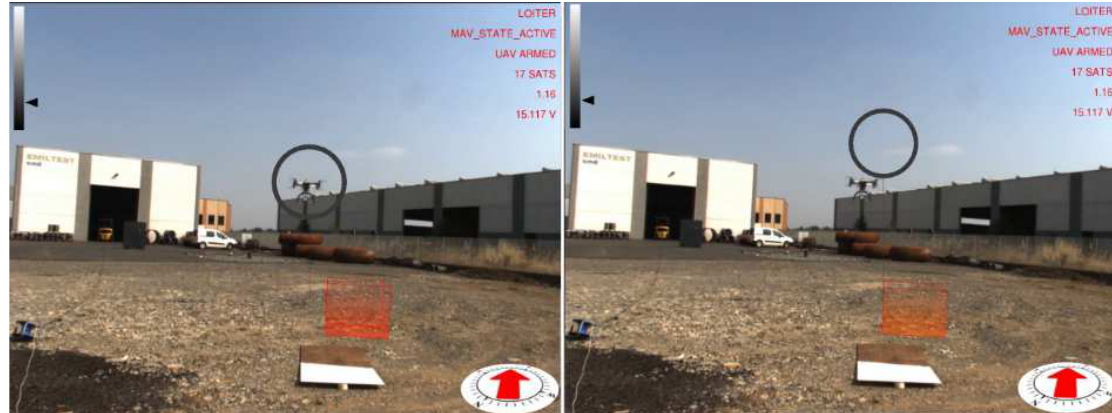
Figure 16. Comparison of UAV position estimation methods: vision-based (left), EKF (onboard sensors) (right). A video of the experiment is available as Supplementary Material (video2).